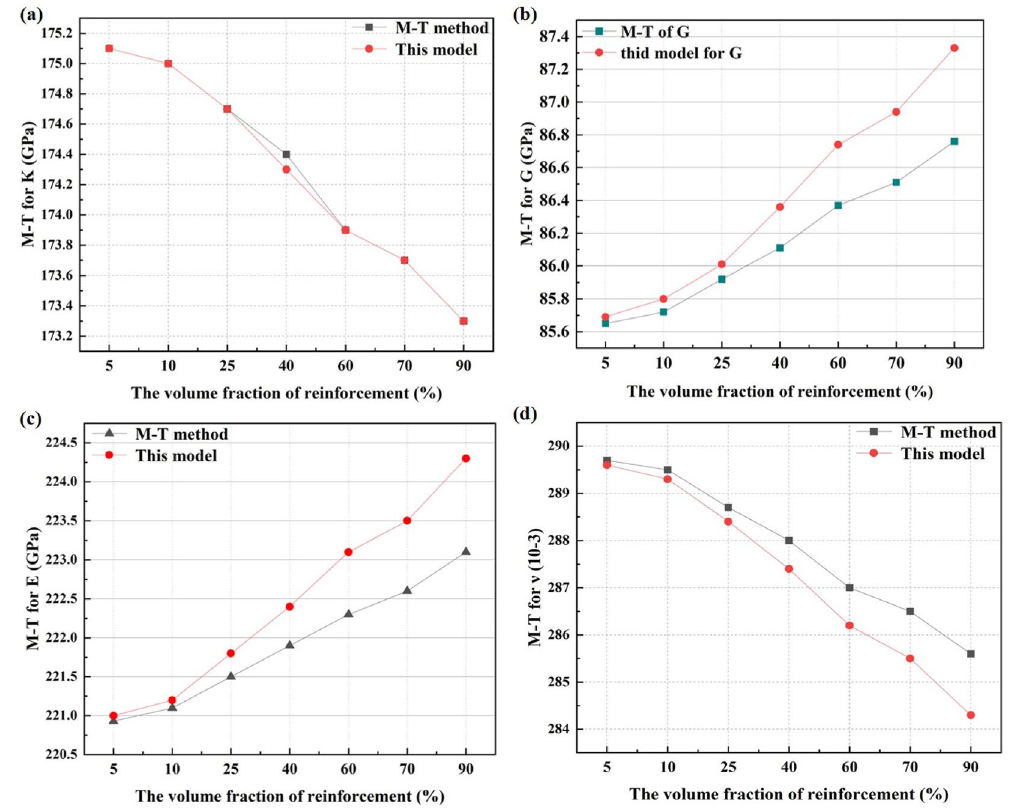
Figure 4. Effect of reinforcement on EECs ( a ) K , G and E ; ( b ) ν